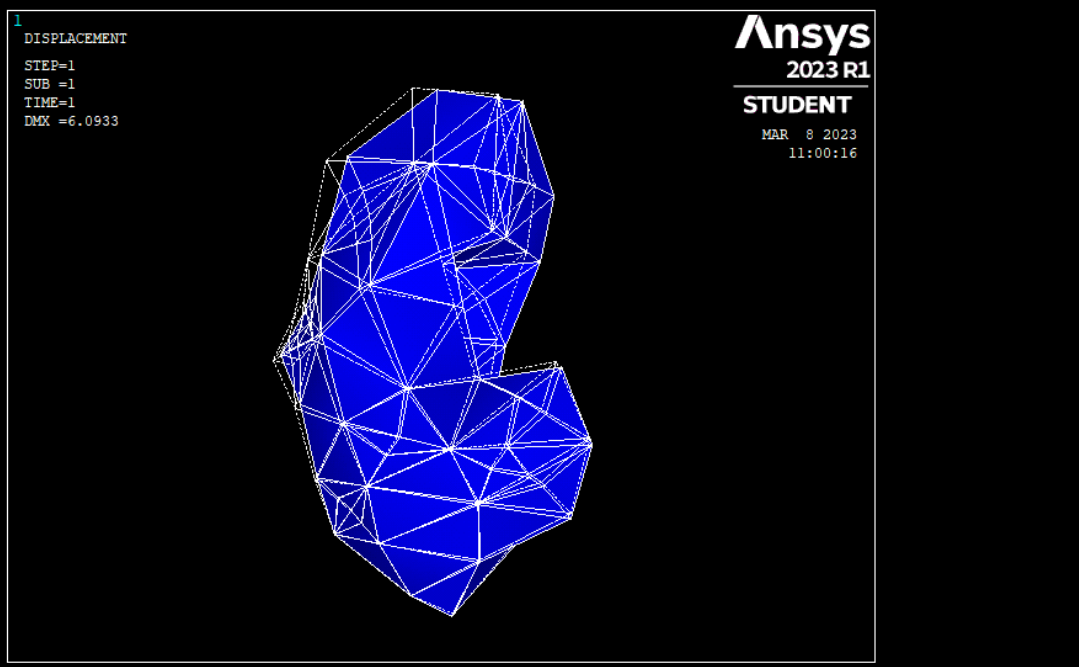
Figure 6. Undeformed and Deformed Geometry for Problem 2 (Nonlinear